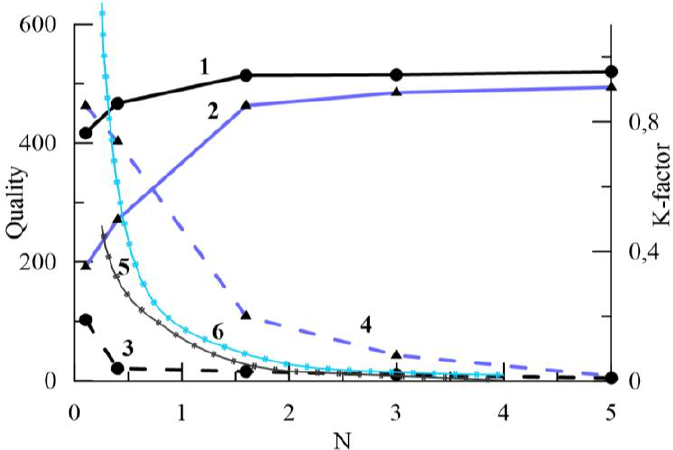
Fig. 6. Dependence of the resonator’s quality of the Fresnel parameter N and K coefficient for lower- frequency symmetric (black curves, 1, 3) and anti-symmetric (gray curves, 2, 4) modes of the Bragg resonator obtained in CST simulations. For comparison, K coefficient obtained using Eqs. (1)-(2) is shown double ticks lines for symmetric (5) and anti-symmetric (6) modes. 5